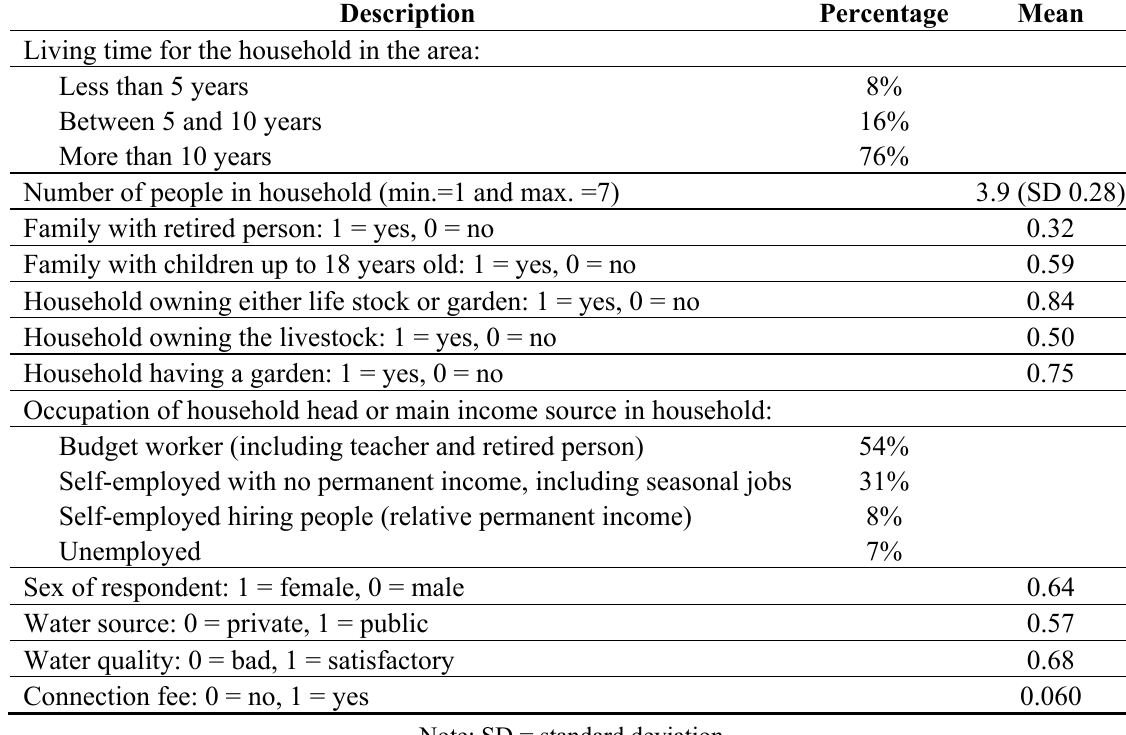
Table A1. Descriptive statistics of survey